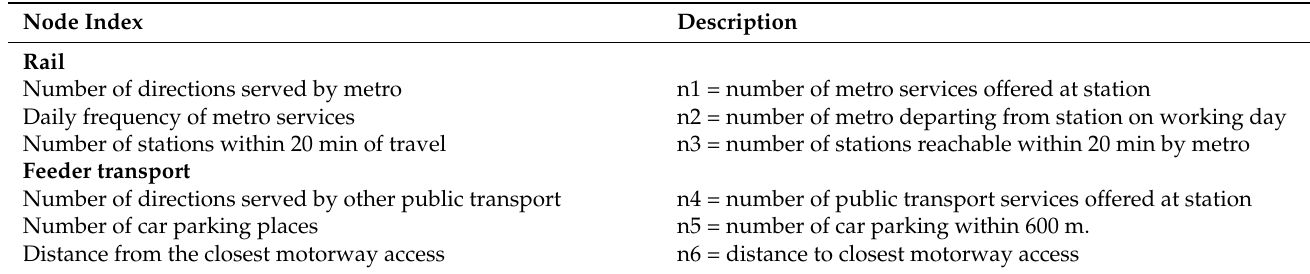
Table 1. Indicators of the node dimension.